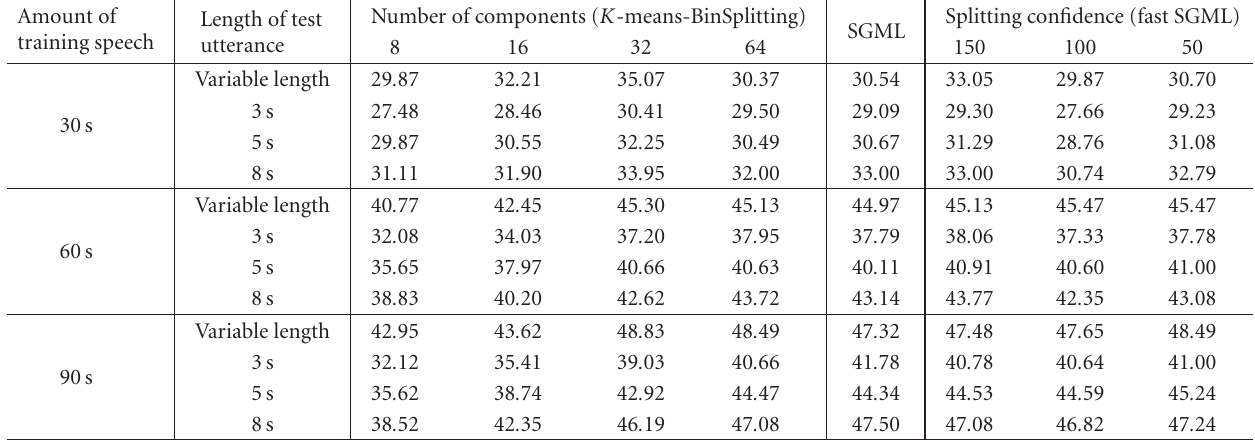
Table 4: Speaker identification accuracy (%) for the female